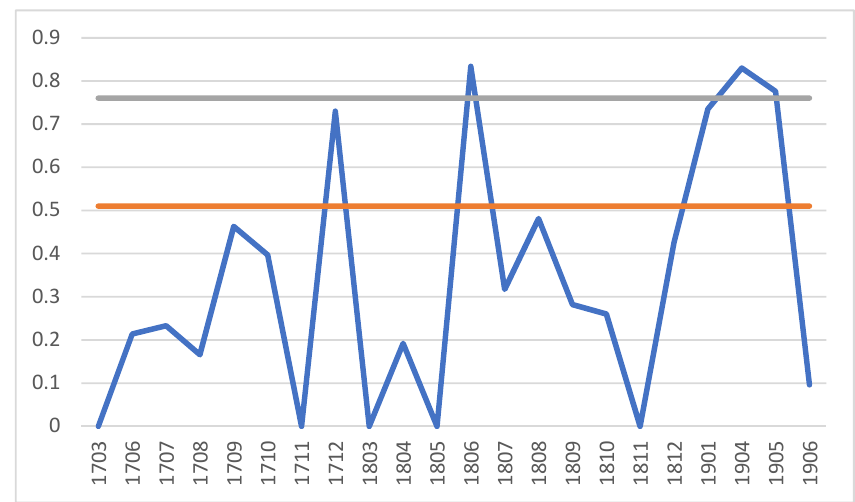
Figure 9. Keyword frequency of the antecedent “Obike”.